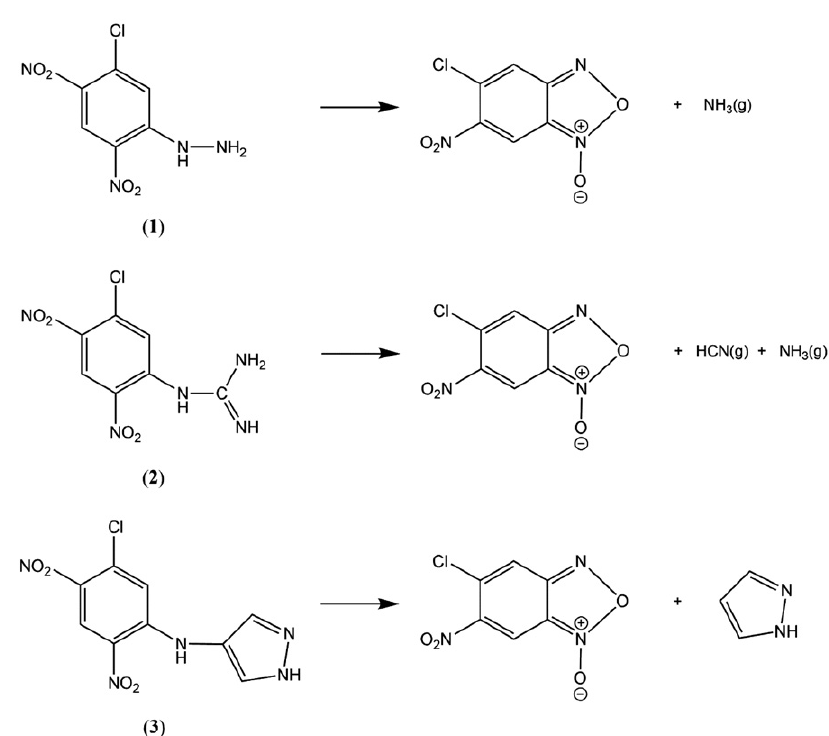
Figure 5. Probable first decomposition reaction of the energetic materials prepared. Table 2. Thermoanalytical data of energetic materials prepared.